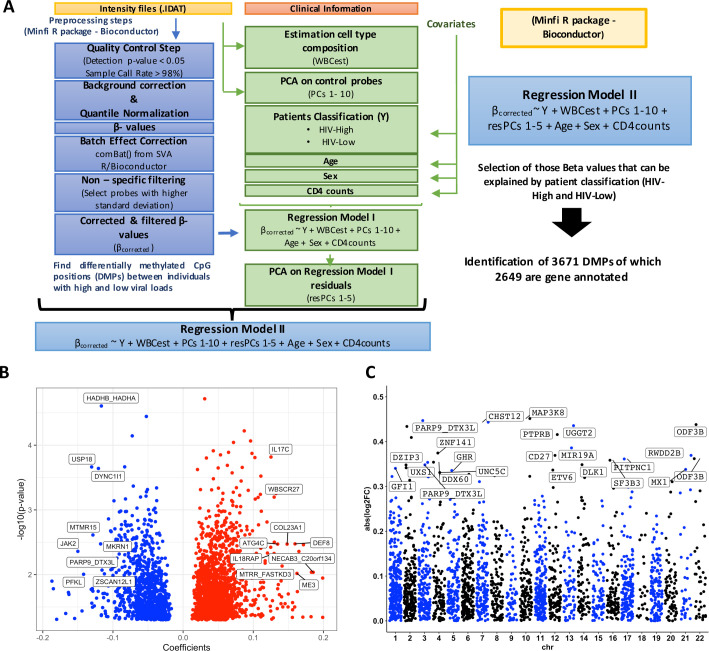
Differentially methylated CpG positions between HIV-1 infected patients with different ranges of plasma viral loads.(A) Analysis strategy for the identification of differentially methylated positions (DMPs). (B) Volcano Plot showing 2,649 gene annotated DMPs (p-value is shown in Y-axis and the regression coefficient from de model on the X-axis). Blue indicates hypomethylation and red, hypermethylation in HIV-High group. Labels indicate top 9 CpG sites with a coefficient higher than |0.1| in HIV-High or HIV-Low. (C) The Manhattan Plot shows the identified DMPs, according the log2 Fold-Change (FC) (Y-axis) and their location on different chromosomes (X-axis).